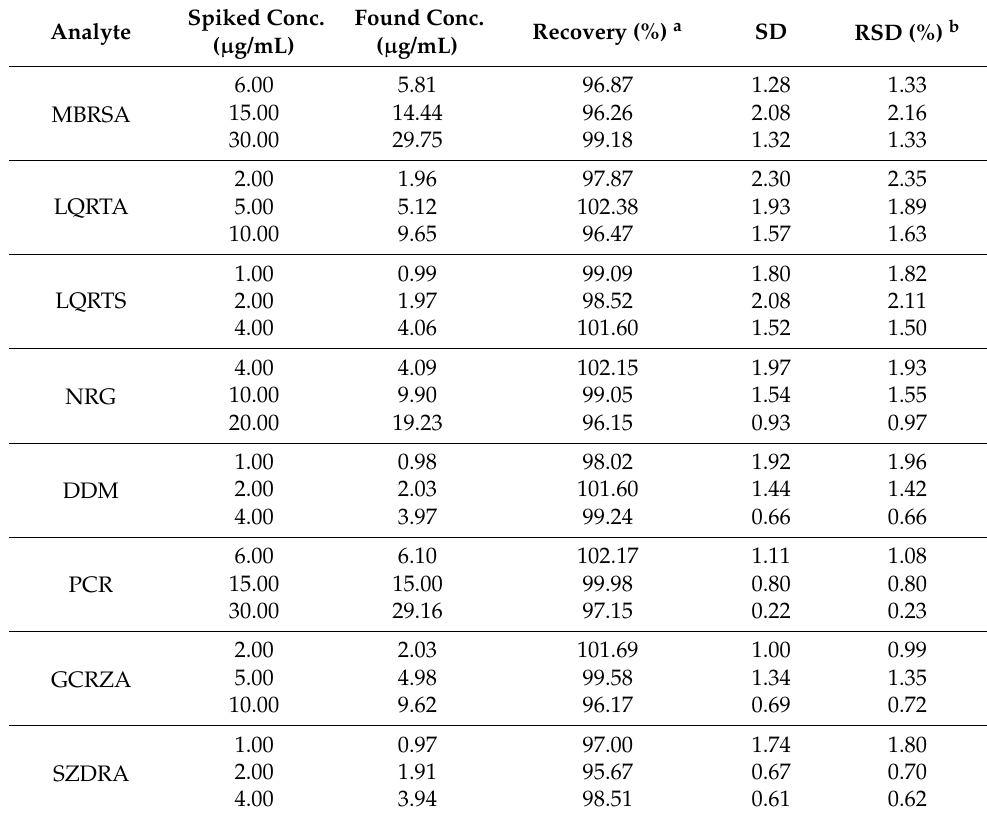
Table 2. Extraction recovery (%) test for the analytical method using eight authentic standards ( n =